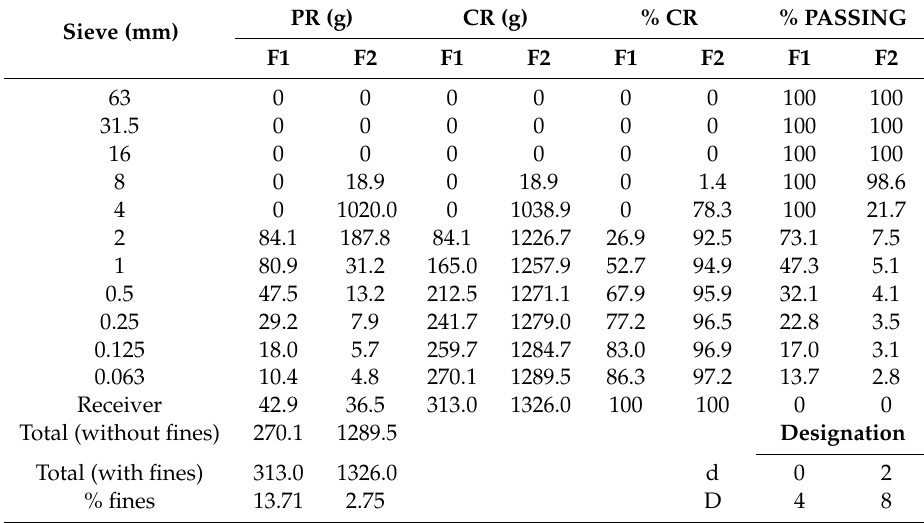
Table 2. Particle size and distribution of the two aggregate fractions used (PR: partially retained; CR: cumulative Retained; F1: fraction 1; F2: fraction